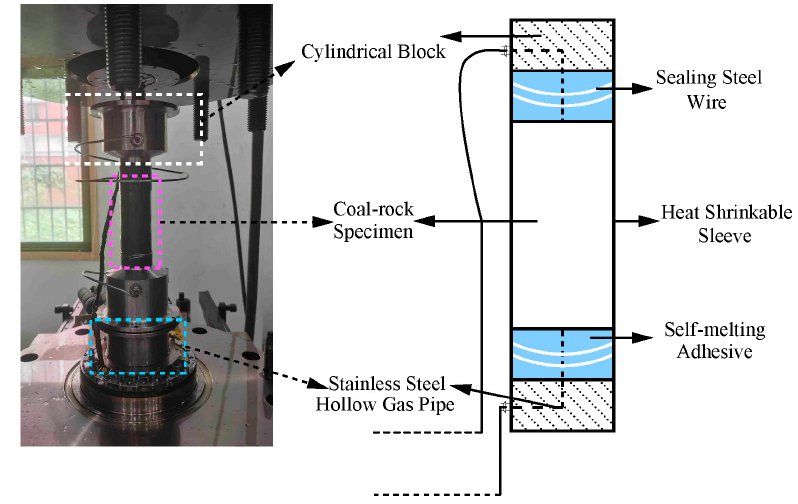
Figure 3. The specimen components.